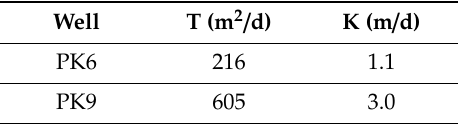
Table 2. Transmissivity (T, m 2 / d) and Hydraulic Conductivity K (m / d) estimated by pumping tests at the wells PK6-5 and PK9-5 [16].